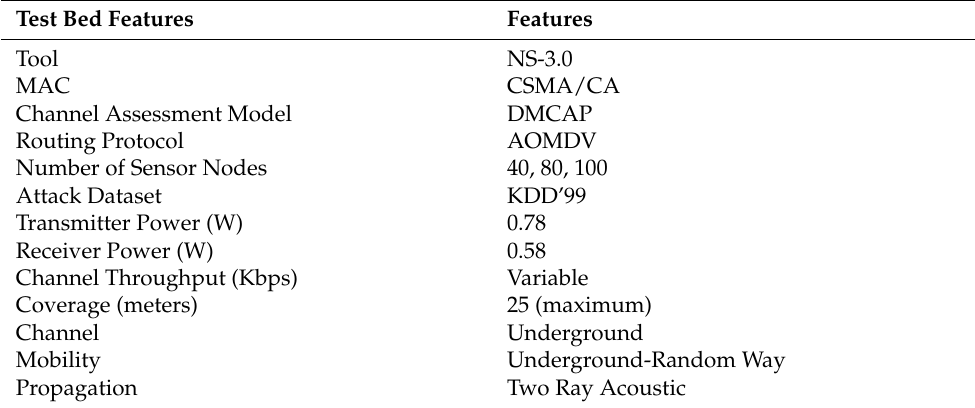
Table 3. WUGSN configuration